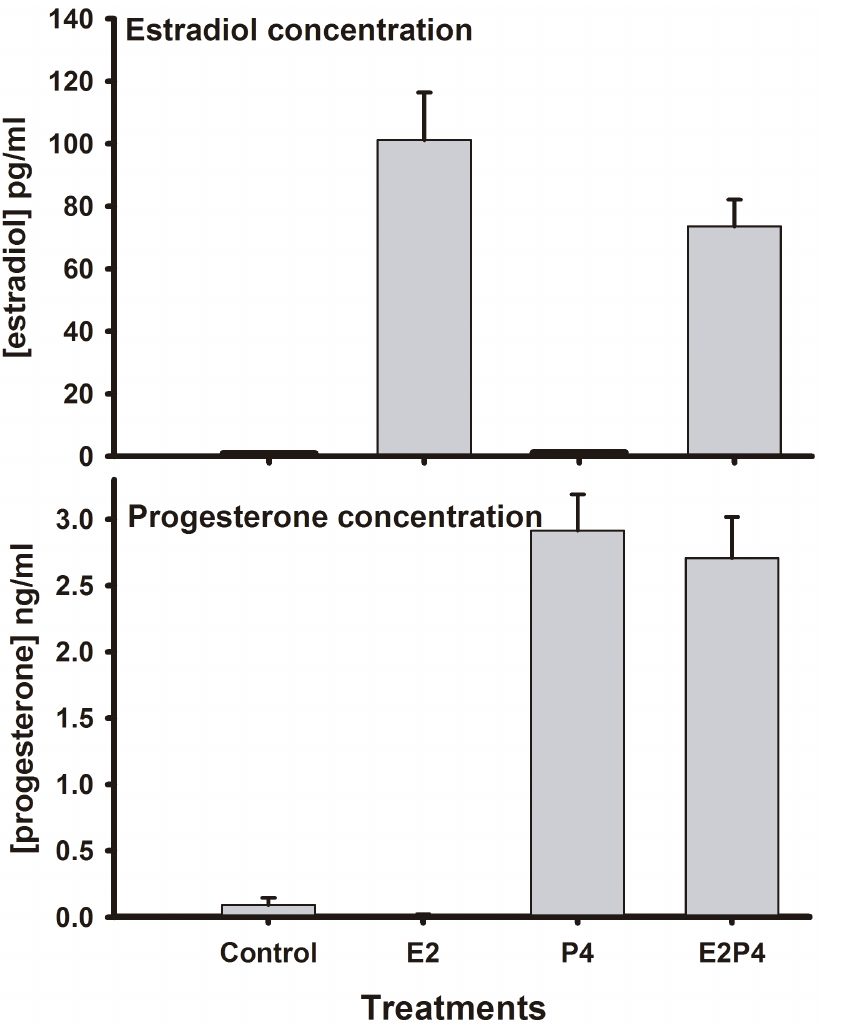
Figure 1. Circulating concentrations of steroid hormones. The daily concentration of estradiol (pg/ml) and progesterone (ng/ml) during hormonal treatment was averaged in this plot (n=8).